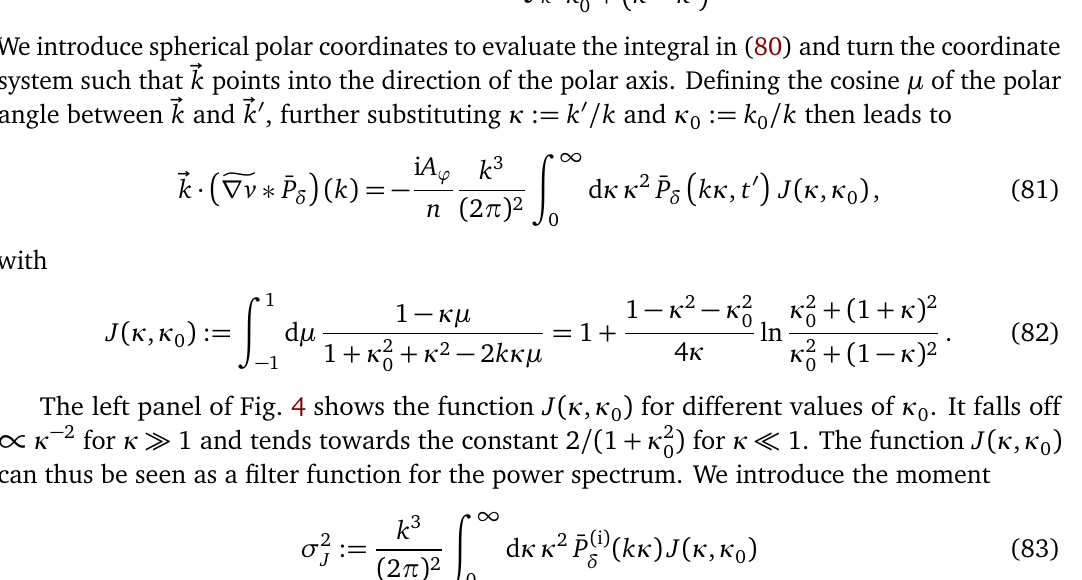
Figure 4: Left panel : The function J ( κ , κ is shown here for five values of κ for κ (cid:29) 1 is unaffected by κ Right panel : Average interaction term 〈 S